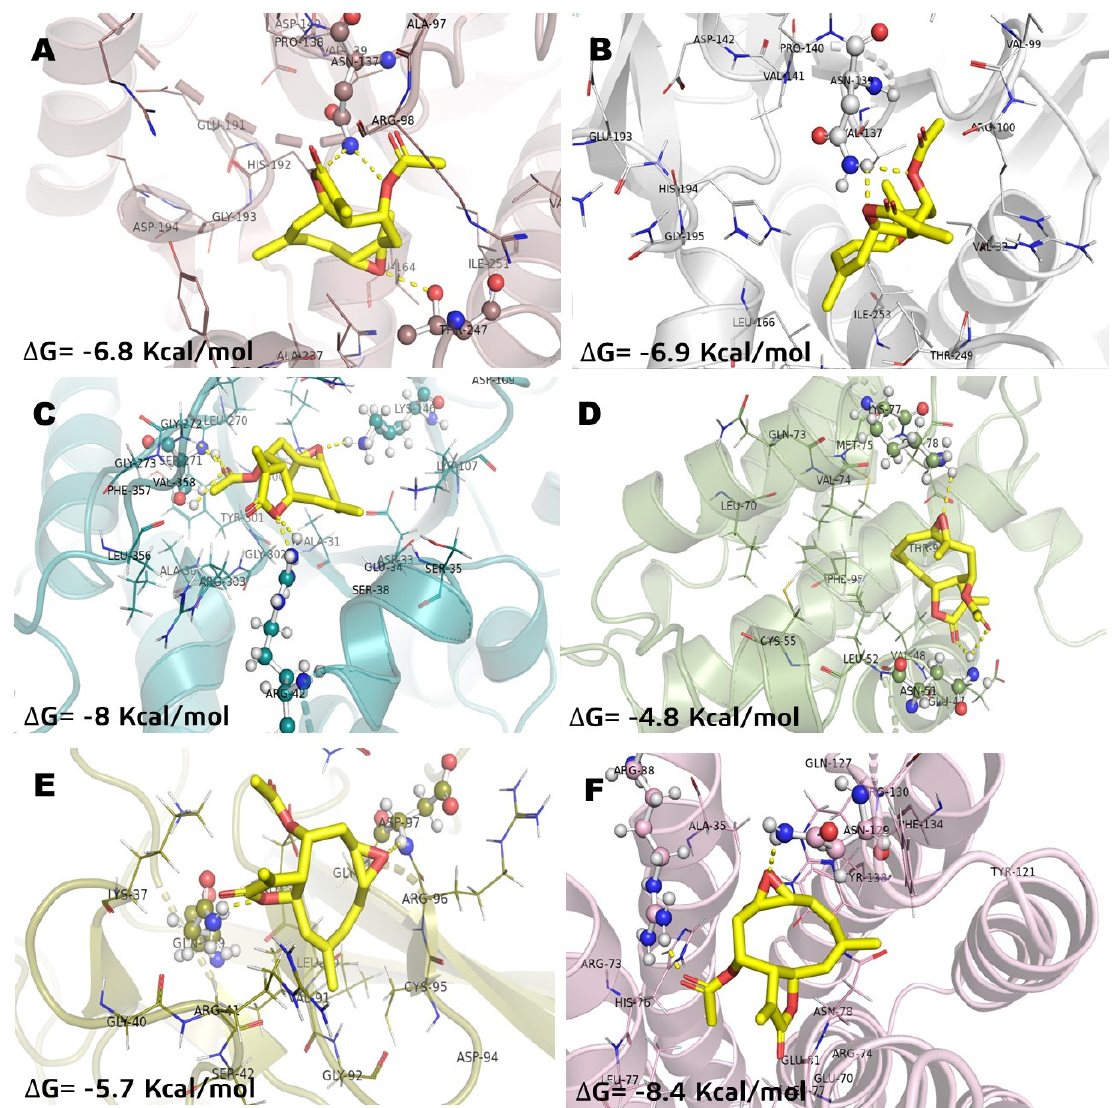
Figure 2. Molecular model of the virtual screening for incomptine A ( IA ) bound to ( A ) L-lactate dehydrogease A chain (LHDA); ( B ) L-lactate dehydrogenase B chain (LDHB); ( C ) Fructose-bisphosphate aldolase (ALDOA); ( D ) Bcl-2-regulator protein A1 (BCL-2A1), ( E ) NF-kappa B p65 (RelA) homodimer (NFkB); and ( F ) Microsomal glutathione S-transferase 1 (MGST1); Δ G = binding energy.